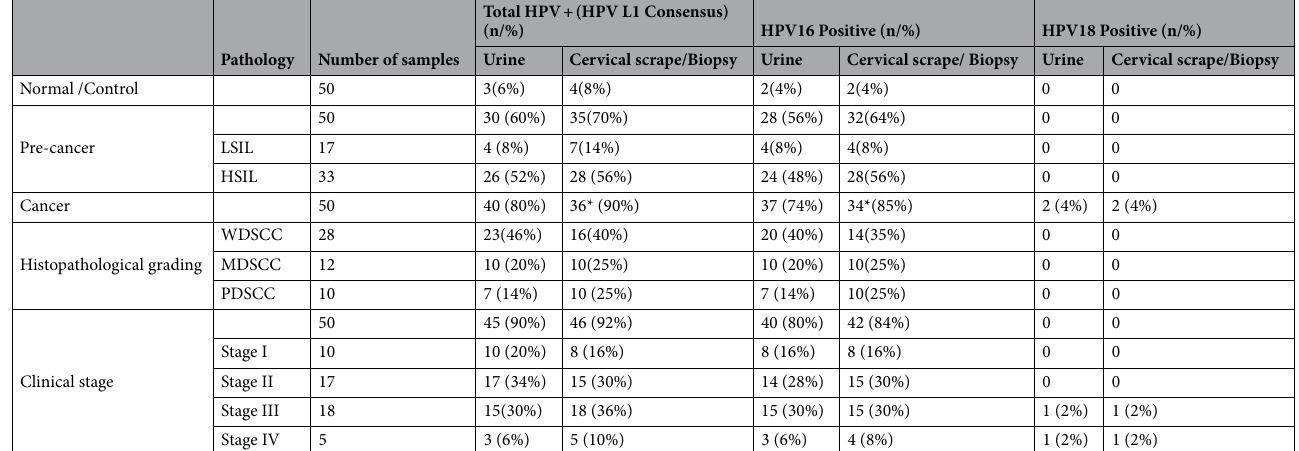
Table 1. Clinicopathological characteristics and HPV status of cervical pre-cancer, cancer patients and controls. *HPV detection conducted in 40 tissue biopsies. HPV human papillomavirus, SCC squamous